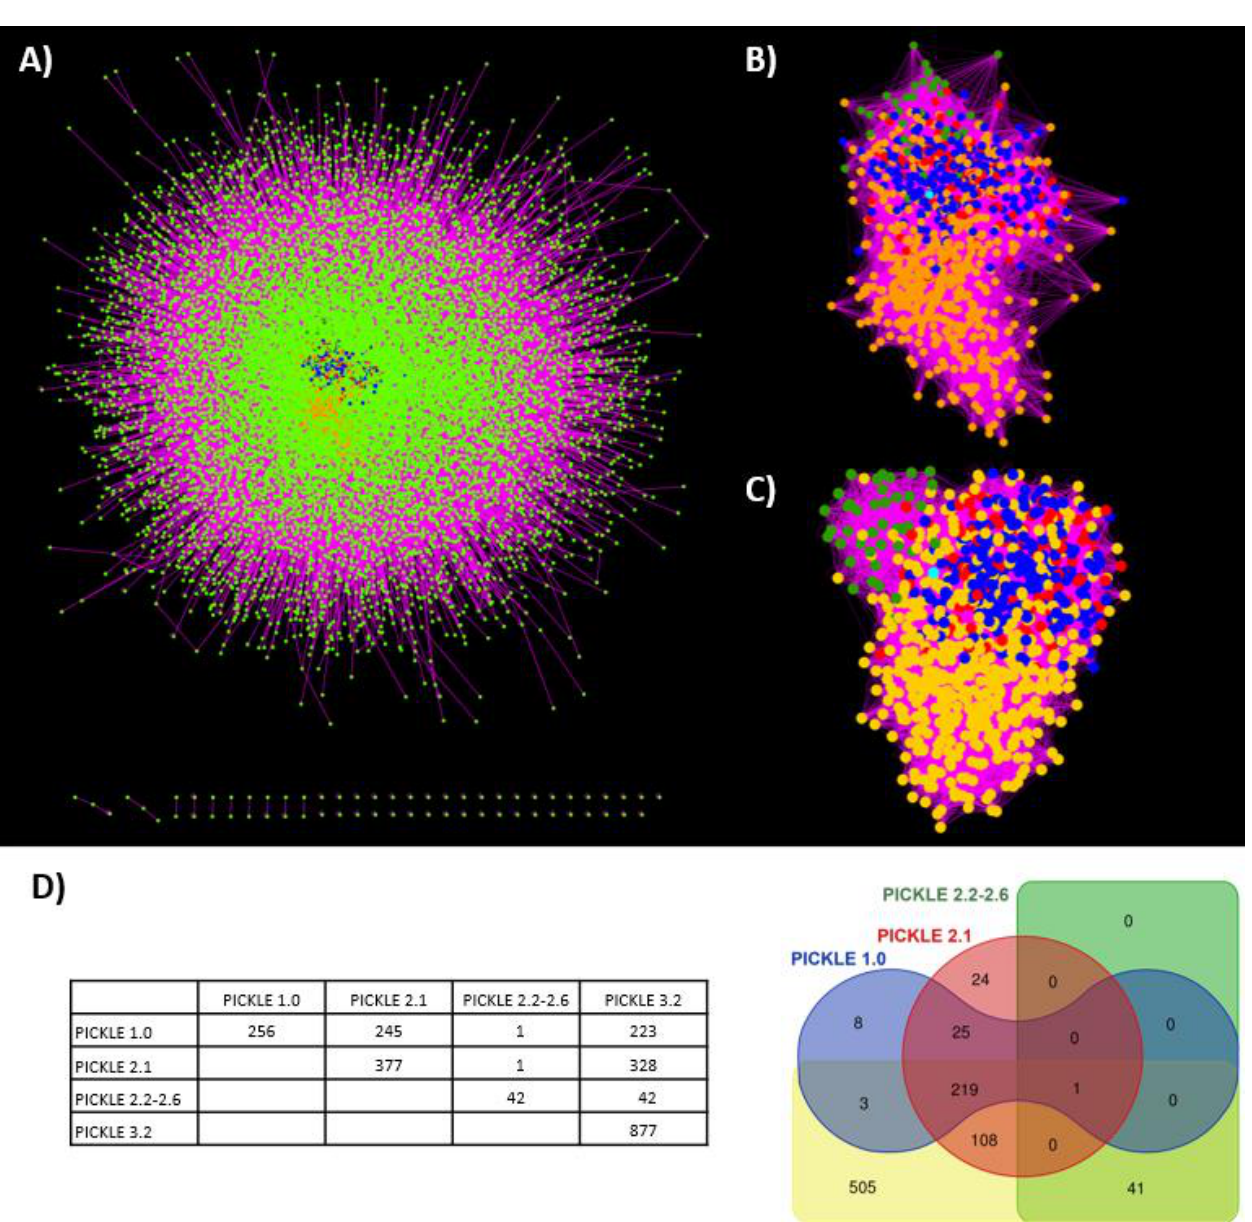
Figure 3. The human protein interactome of PICKLE 3.2 and its k-core in relation to the k-cores of previous PICKLE releases. ( A ) The position of the k-core in the PICKLE 3.2 network; ( B ) The k-core as extracted from the full network and ( C ) the k-core in force-directed layout; ( D ) the correlation matrix and the Venn diagram of the k-cores of the various PICKLE releases. Blue, red and green nodes depict, respectively, the proteins in the k-core intersection of PICKLE 3.2 with PICKLE 1.0 (222 proteins) or PICKLE 2.1 (108 proteins; the 219 proteins common with PICKLE 1.0 are depicted in blue) or PICKLE 2.2-2-6 (41 proteins). The unique PICKLE 3.2 k-core protein-nodes are colored yellow. The common protein in all k-cores, P56524 – HDAC1_HUMAN, is depicted in cyan.